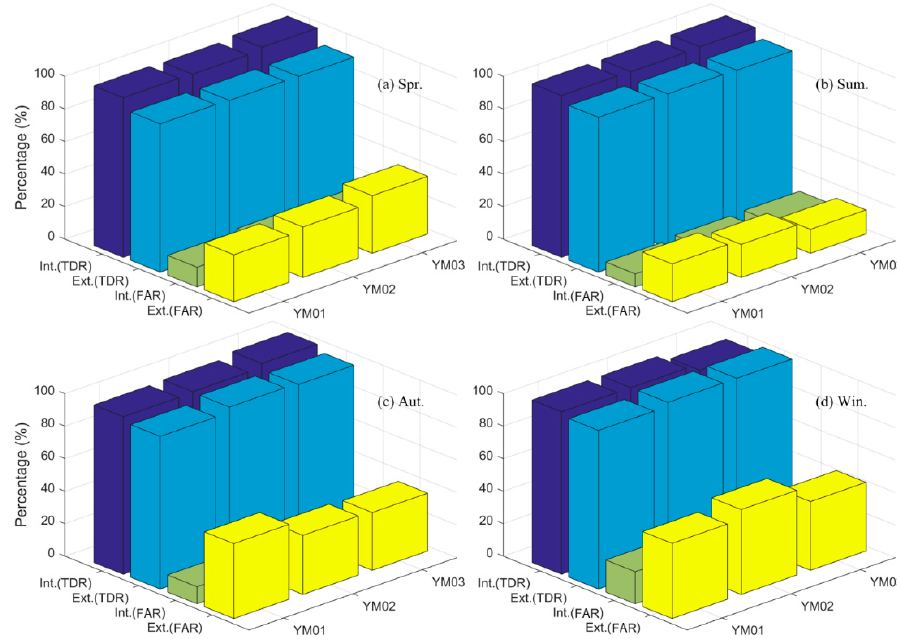
Figure 6. Statistical comparison of the internal and external coincidence accuracy of the nonlinear method-based rainfall forecast model at the three stations. Int. represents the internal coincidence accuracy; Ext. represents the external coincidence accuracy. Table 3. The data period used in the internal and external experiments in different seasons.